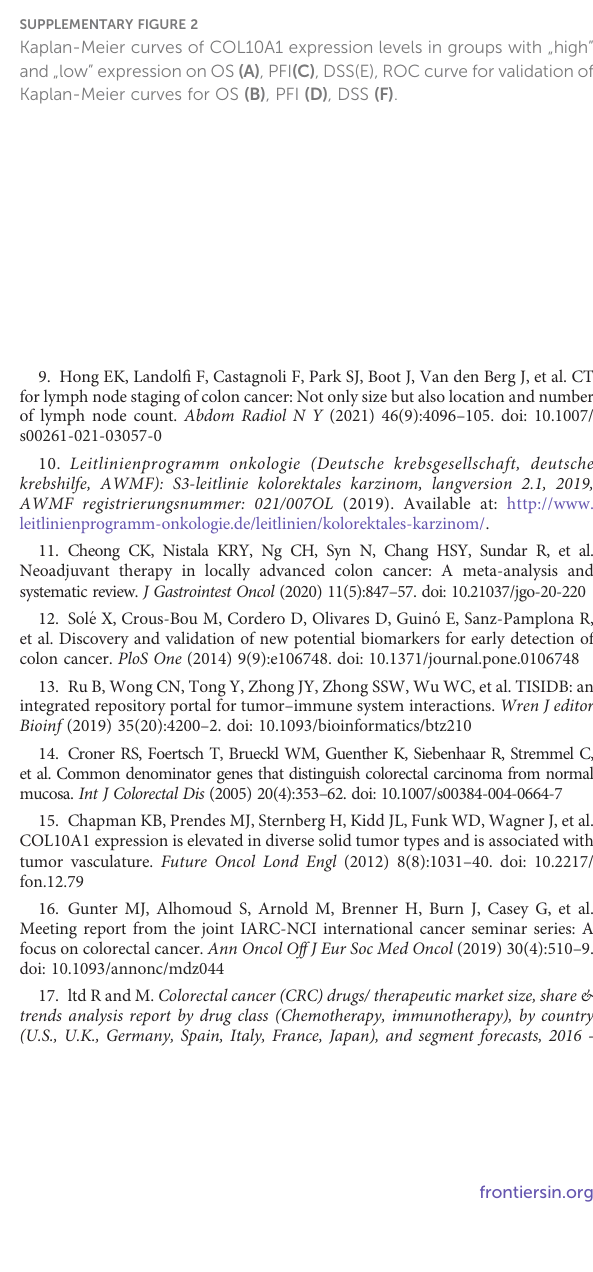
SUPPLEMENTARY FIGURE 1 COL10A1 expressionlevels.COL10A1 expressionishighinCAFcellcluster (A, B) as well as in fi broblasts (C) . SUPPLEMENTARY FIGURE 2 Kaplan-Meier curves of COL10A1 expression levels in groups with „ high ” and „ low ” expression on OS (A) , PFI (C) , DSS(E), ROC curve for validation of Kaplan-Meier curves for OS (B) , PFI (D) , DSS (F)